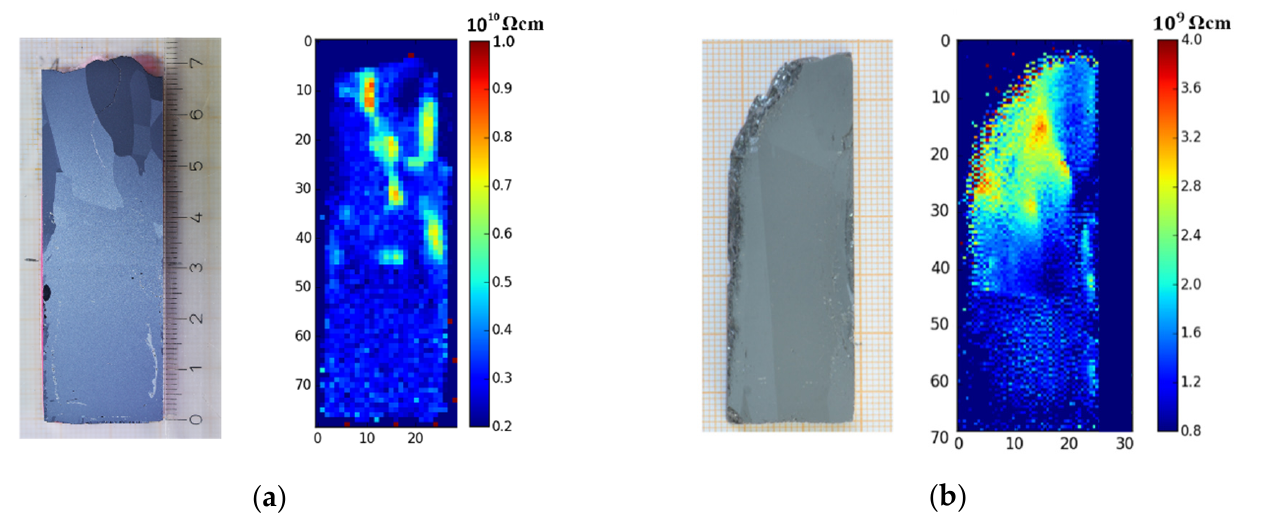
Figure 8. Contactless resistivity mapping of: ( a ) F1-02 and ( b ) F1-03.